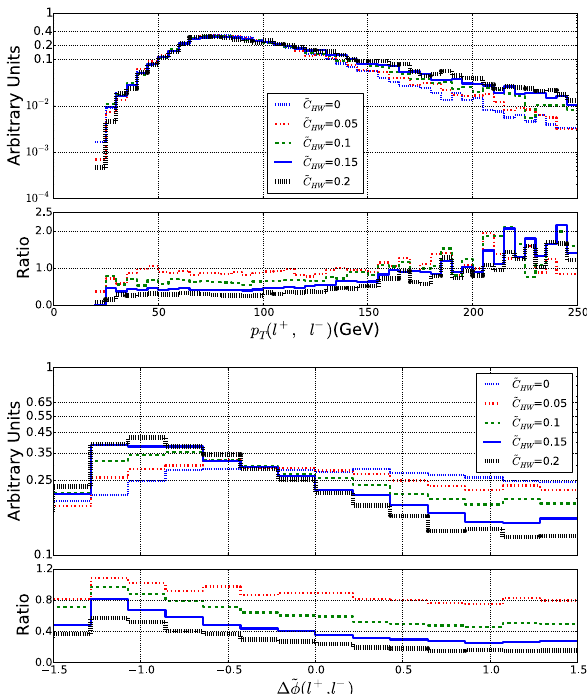
Fig. 5 Representative kinematical properties of a dilepton system issued from the decay of a Z -boson when the latter is produced in asso- ciation with a Higgs boson in LHC collisions at a center-of-mass energy of 13 TeV. We consider the scalar sum of the transverse momenta of the two leptons (top) and their angular separation in azimuth (bottom). We allow for different values for the ˜ c HW parameter and we present, in the lower panels, the bin-by-bin ratio of the new physics predictions to the Standard Model